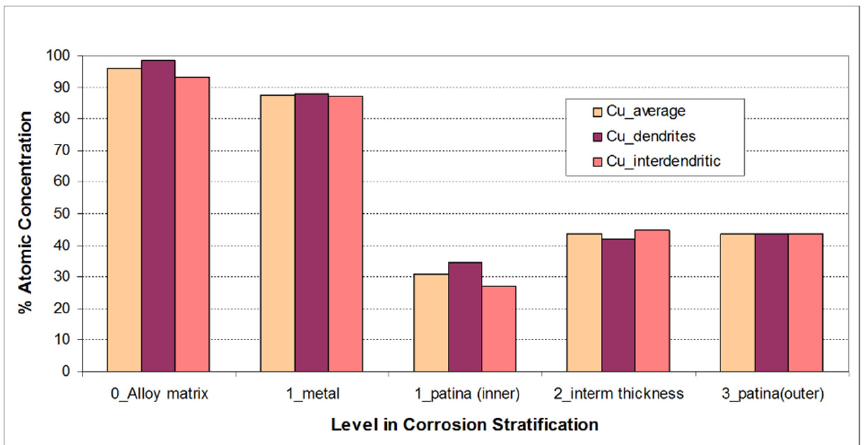
Figure 11. % Cu atomic concentration profile of the corrosion layer stratification in dendritic and interdendritic areas after TB anodic polarization in 0.1 mol/L NaCl—Based on EDS elemental chemical analyses data (fullframe and spot analyses).